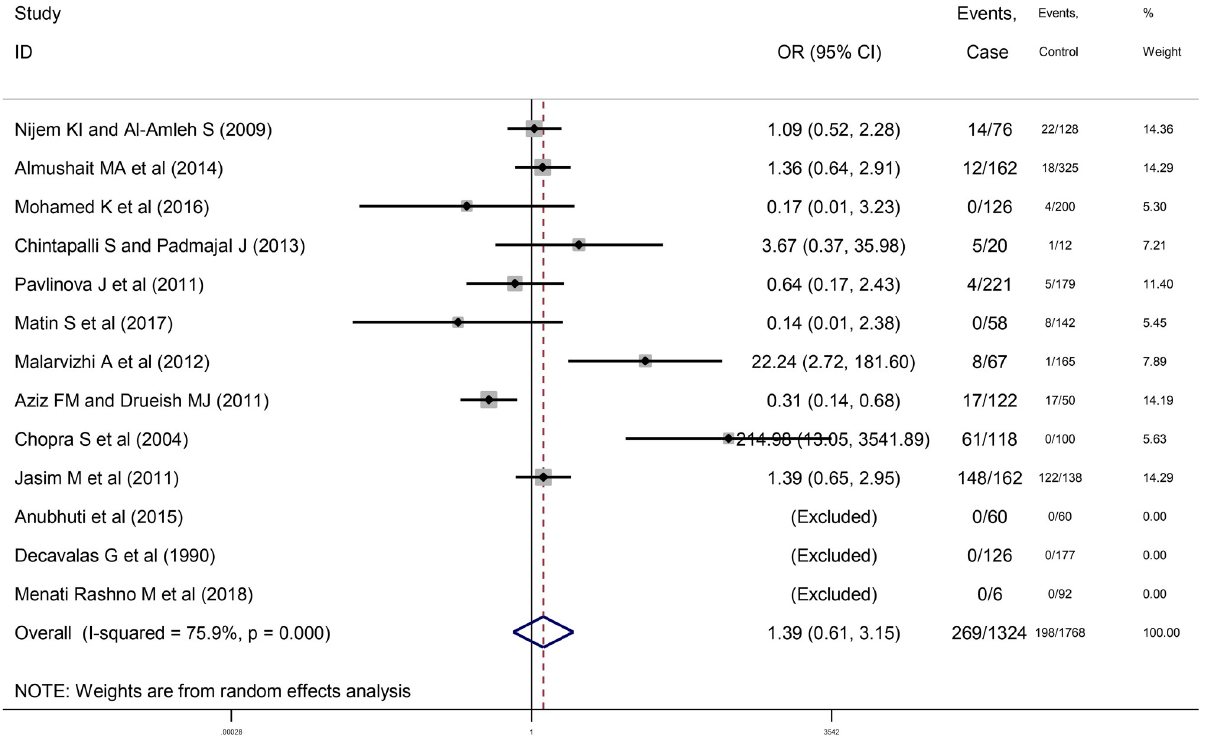
Fig 6. Forest plot diagram of cross-sectional studies showing IgM seropositivity rates of T . gondii .